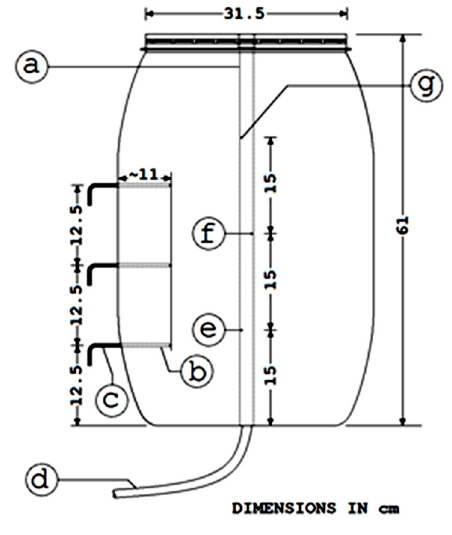
Figure 2. Configuration of each investigated barrel. (a) perforated tube of 0.5 in internal diameter, (b) temperature digital sensor, (c) cable, (d) air and water vapor mixture inlet, (e) two opposite holes of 4 mm diameter (f) like (part: e) but staggered from it by a circular arc of 2.5 cm, and (g) like (part: f) but staggered from it by a circular arc of 2.5 cm.